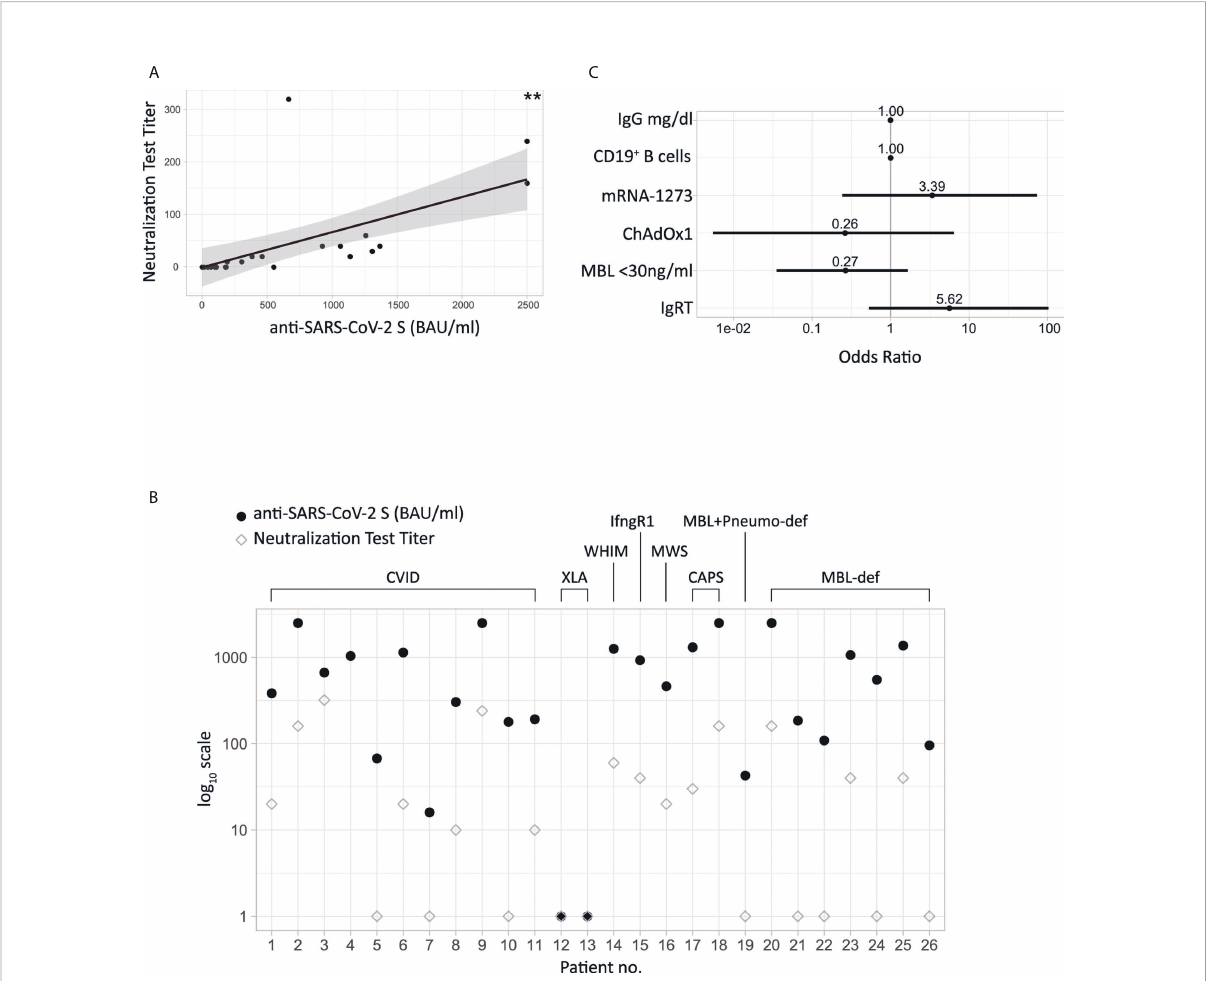
FIGURE 2 (A) Scatter plot of neutralizing test titers and anti-SARS-CoV-2 S with linear regression line. The double asterisk indicate a p<0.001. (B) Levels of anti-SARS-CoV-2 S in combination with titers of neutralizing antibodies are shown for the individual patients (C) ORs of logistic regression analyses assessing neutralizing antibody titers against SARS-CoV-2Virus. MBL-de fi ciency was de fi ned as MBL <30ng/ml. IgRT: Immunoglobulin replacement therapy. Reference vaccine to the ORs of ChAdOx1 and mRNA-1273 is